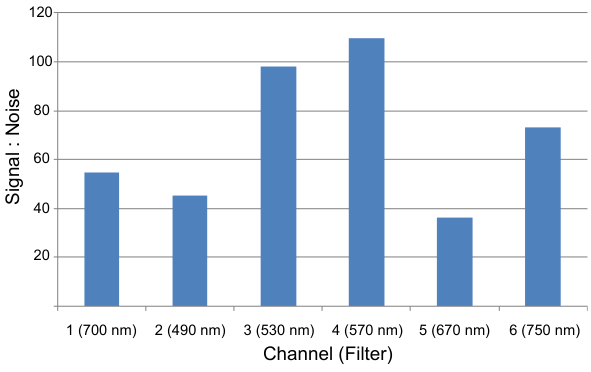
Figure 5: SNR of UAV Salt Marsh Test Image Bands